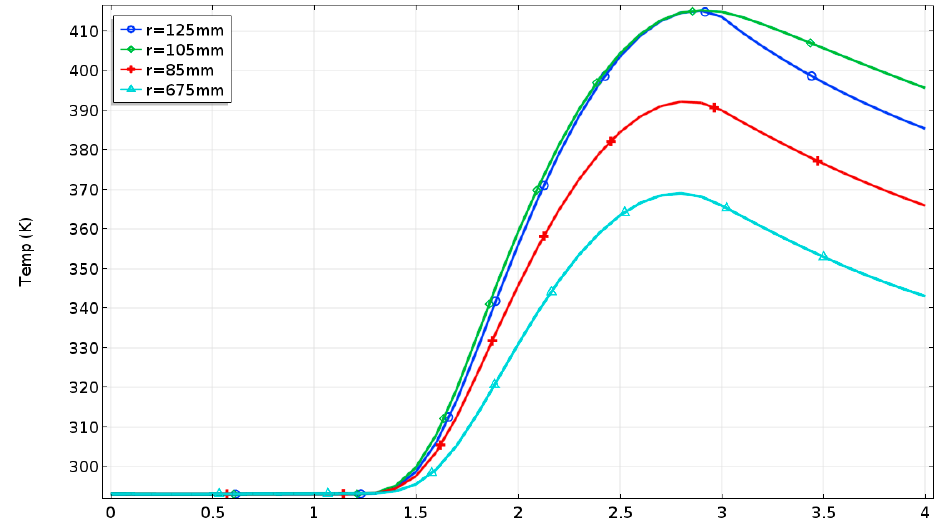
Figure 8. Radial temperature distribution of friction brake surface.